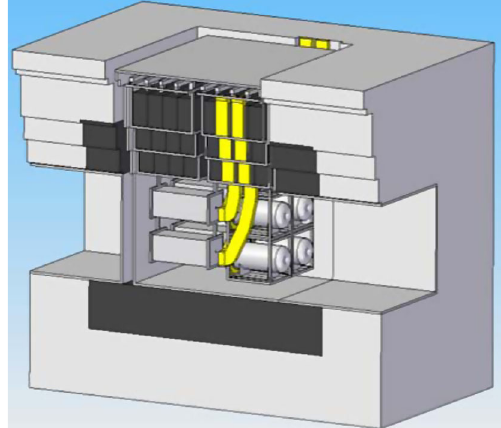
FIG. 6. Conceptual design of the section of the target station for the four targets and horn systems. The beam enters from the left. The horn pulsing circuits will be mounted on top of the shielding, so the strip lines exit vertically.